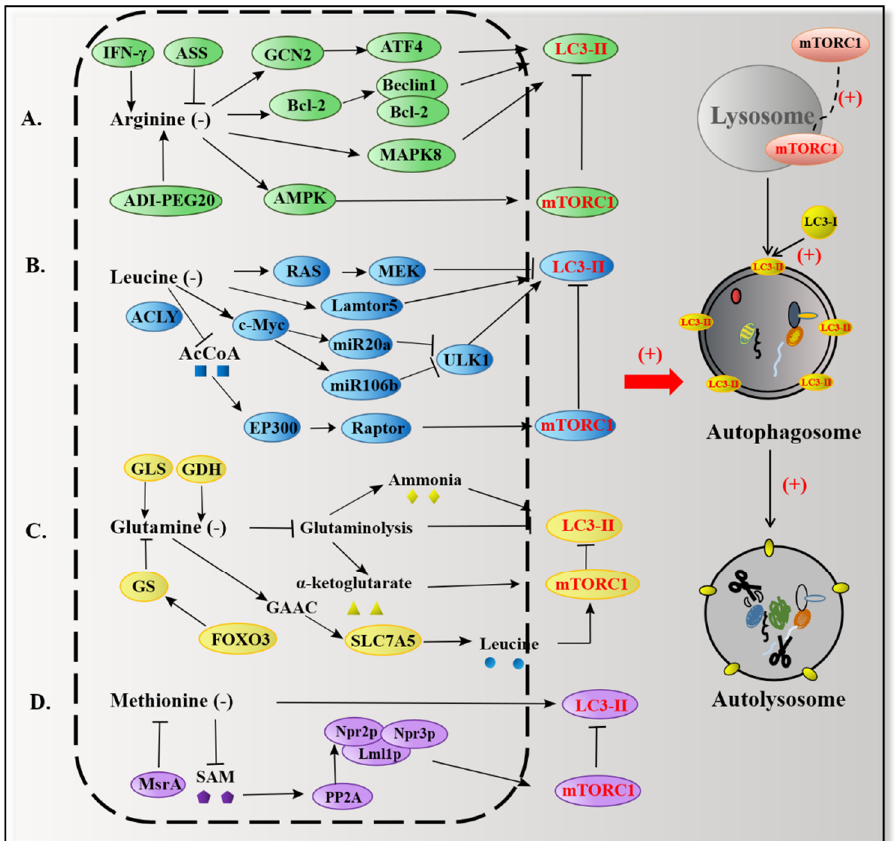
Figure 4. Specific amino acids regulate autophagy by inhibiting mTORC1 and increasing LC3-II expression. (The red arrow connects the left to right side of the diagram, representing the transition from mechanism to function; plus signs are used to present that amino acids promote autophagy.)